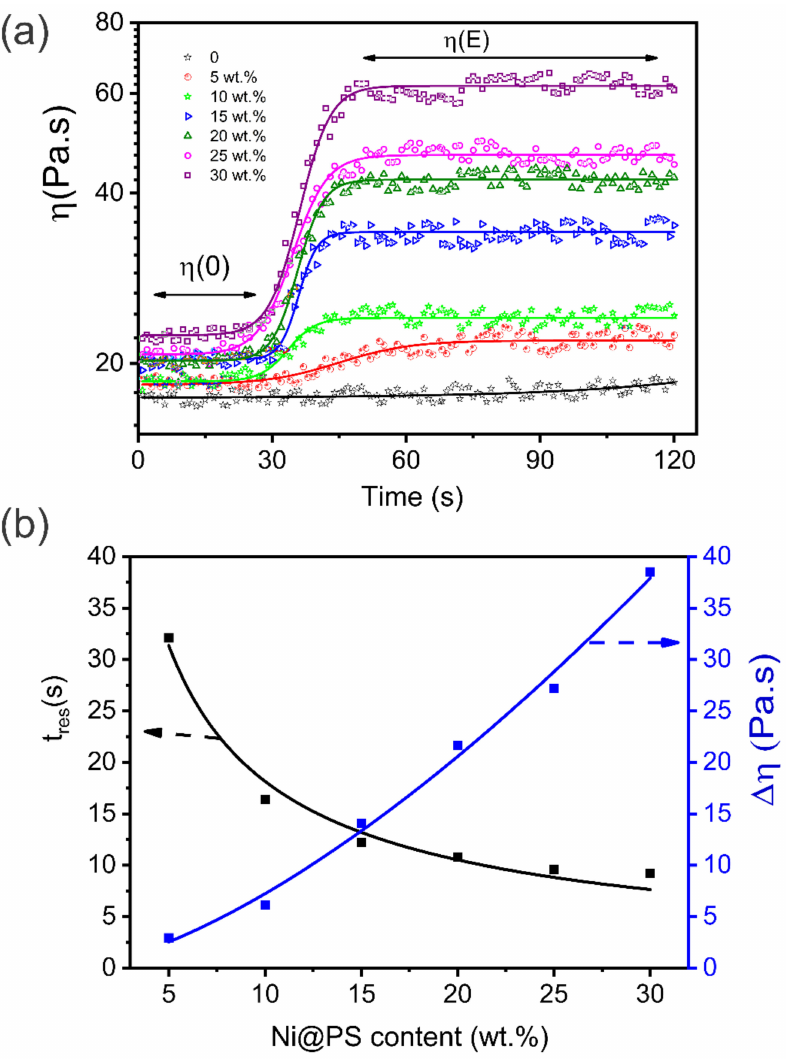
Figure 6. ( a ) Plots of the shear viscosity vs. time at constant shear rate, as a function time under different electric field strength. The field is applied at t = 30 s. Lines correspond to the best fit to a Sigmoidal-Boltzmann curve. ( b ) Viscosity increases ( ∆ η ) and response time ( t res ) vs. Ni@PS